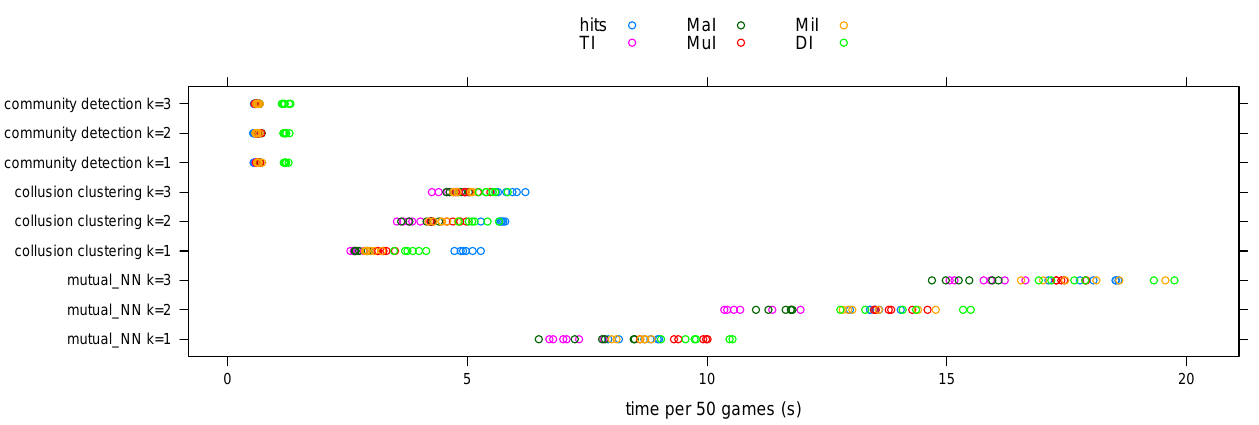
time per 50 games (s)